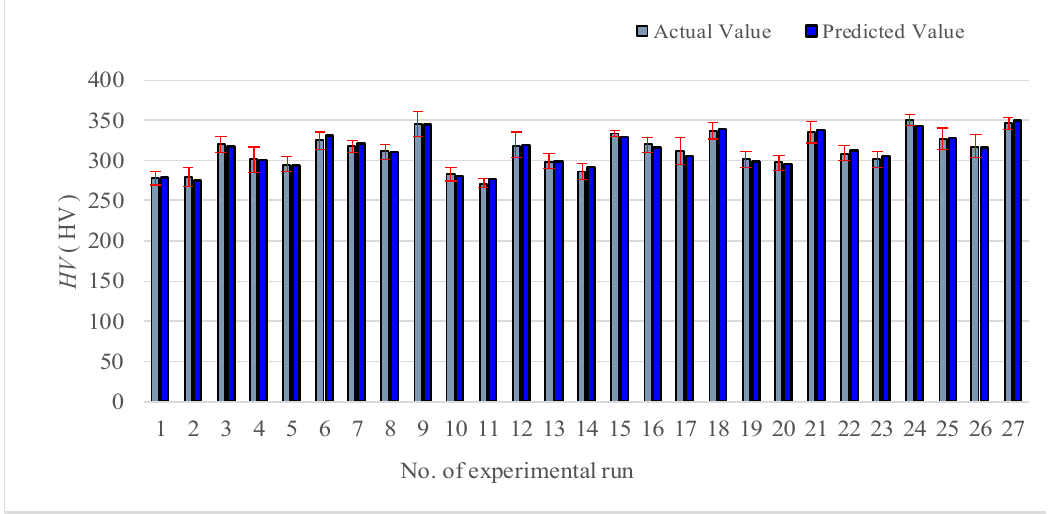
Figure 9. Comparison chart between predicted value and measured value ( HV ).